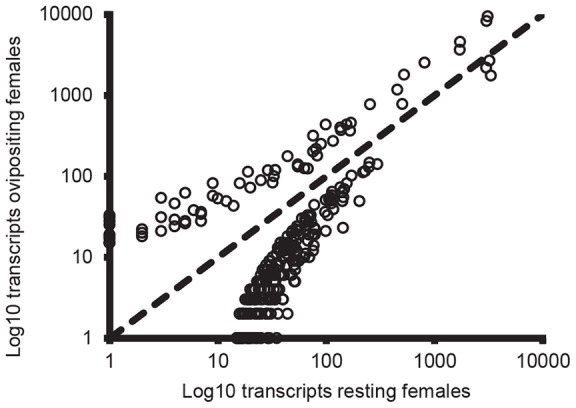
Differentially expressed tags between resting and ovipositing Nasonia vitripennis females.Total transcript abundance by treatment for the 322 tags differentially expressed between resting and ovipositing Nasonia vitripennis females (summed across N = 8 biological replicates per treatment). Approximately 77% of these tags show higher expression levels in resting females. The dotted line indicates a 1:1 relationship. All tags with total abundance across both treatments of <16 counts were excluded from the analysis.